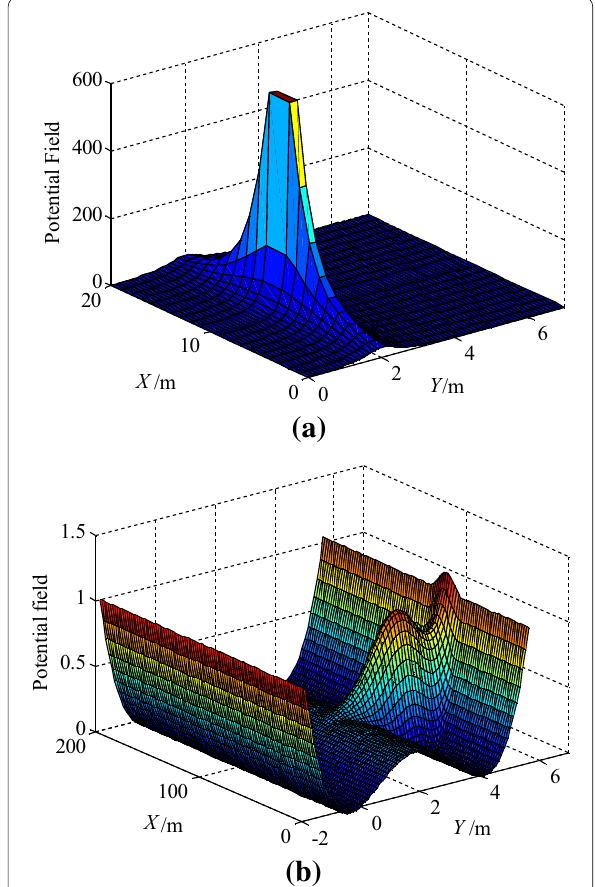
Figure 4 Examples of the potential field: ( a ) The non-crossable area; ( b ) The crossable area and road